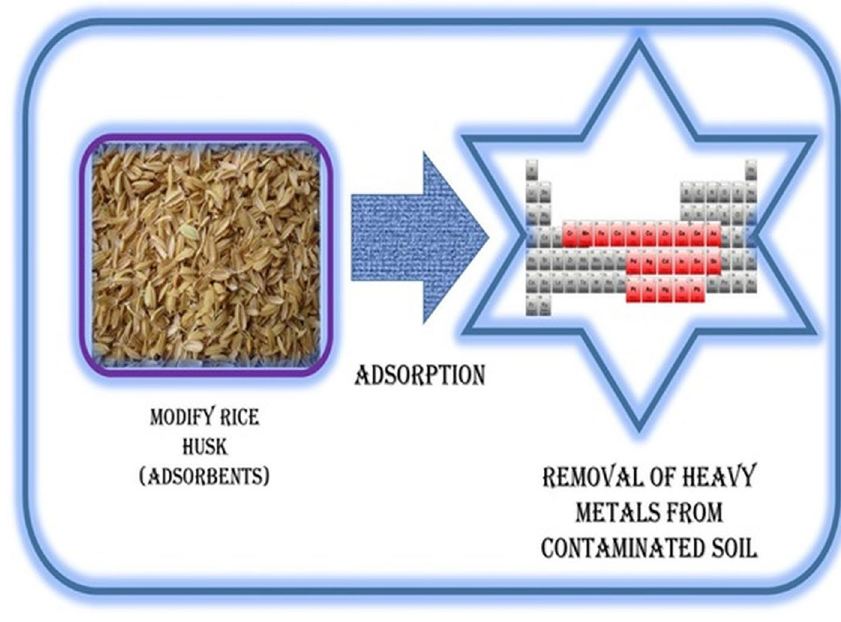
Fig. 3 Schematic representa- tion of HM removal from soil contamination using modified rice husk